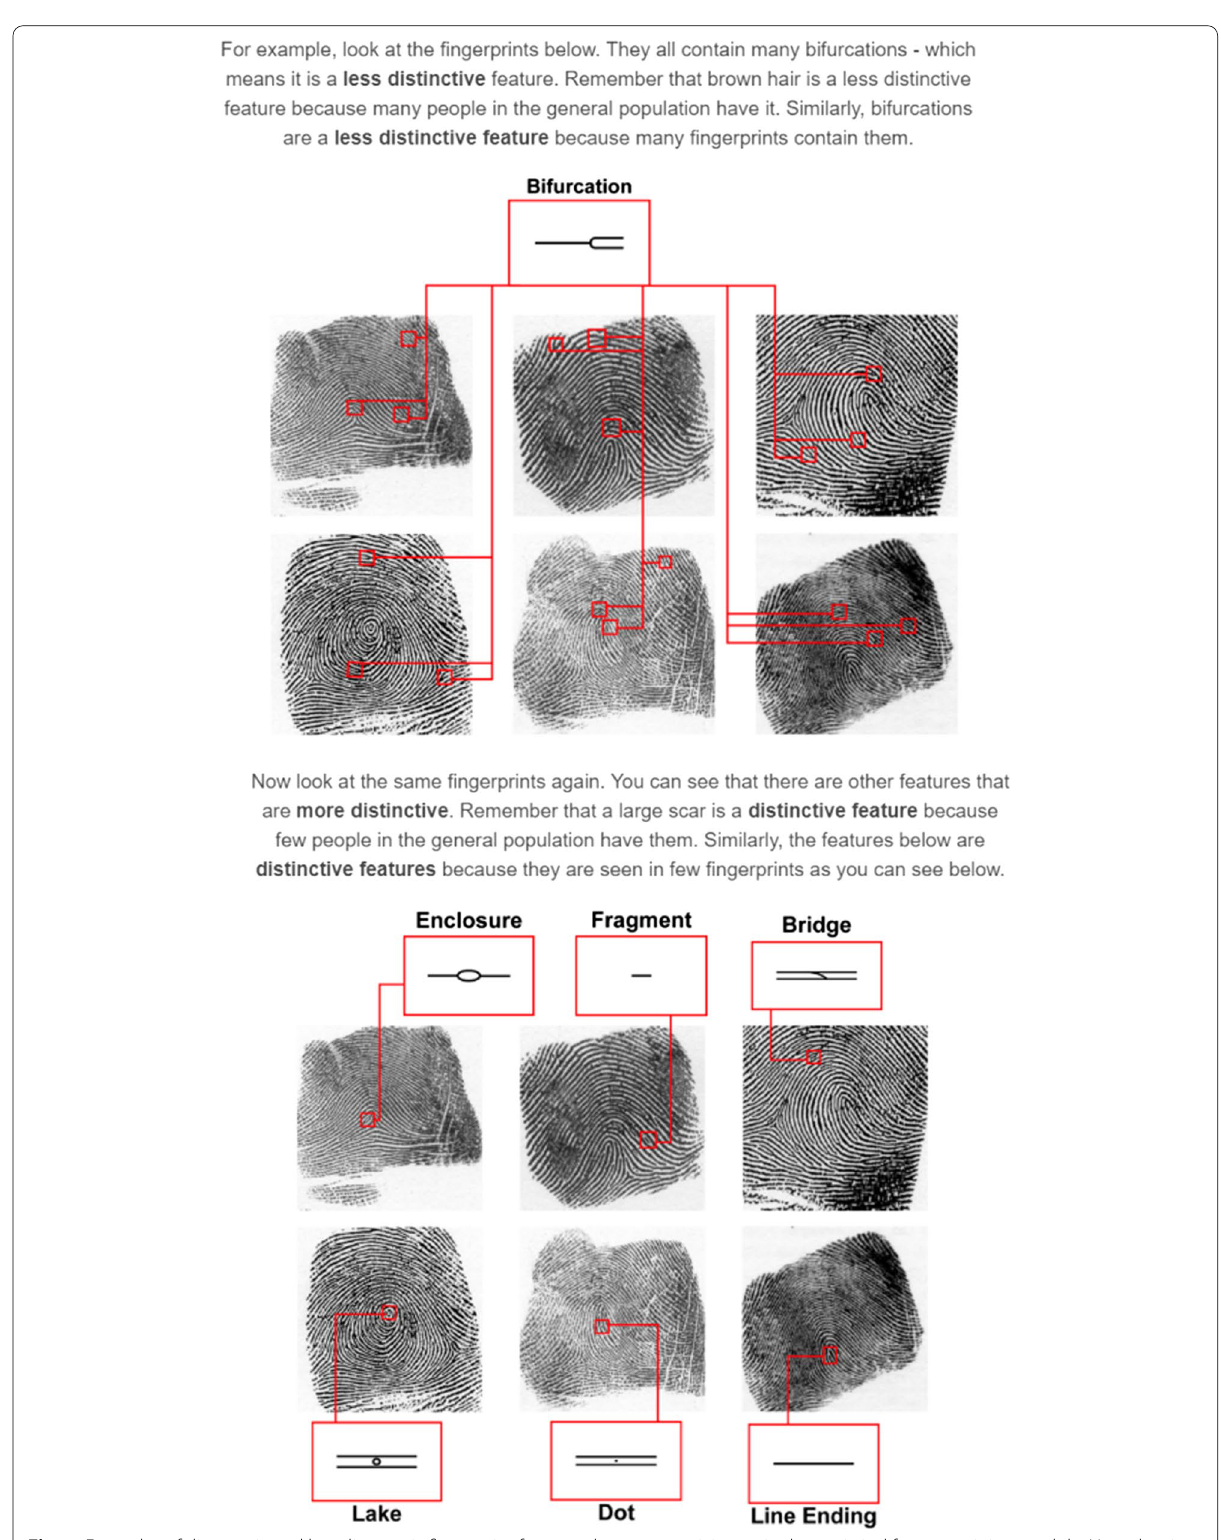
Fig. 4 Examples of diagnostic and less diagnostic fingerprint features shown to participants in the statistical feature training module. Note the size of these images has been scaled for the manuscript and the images participants viewed were